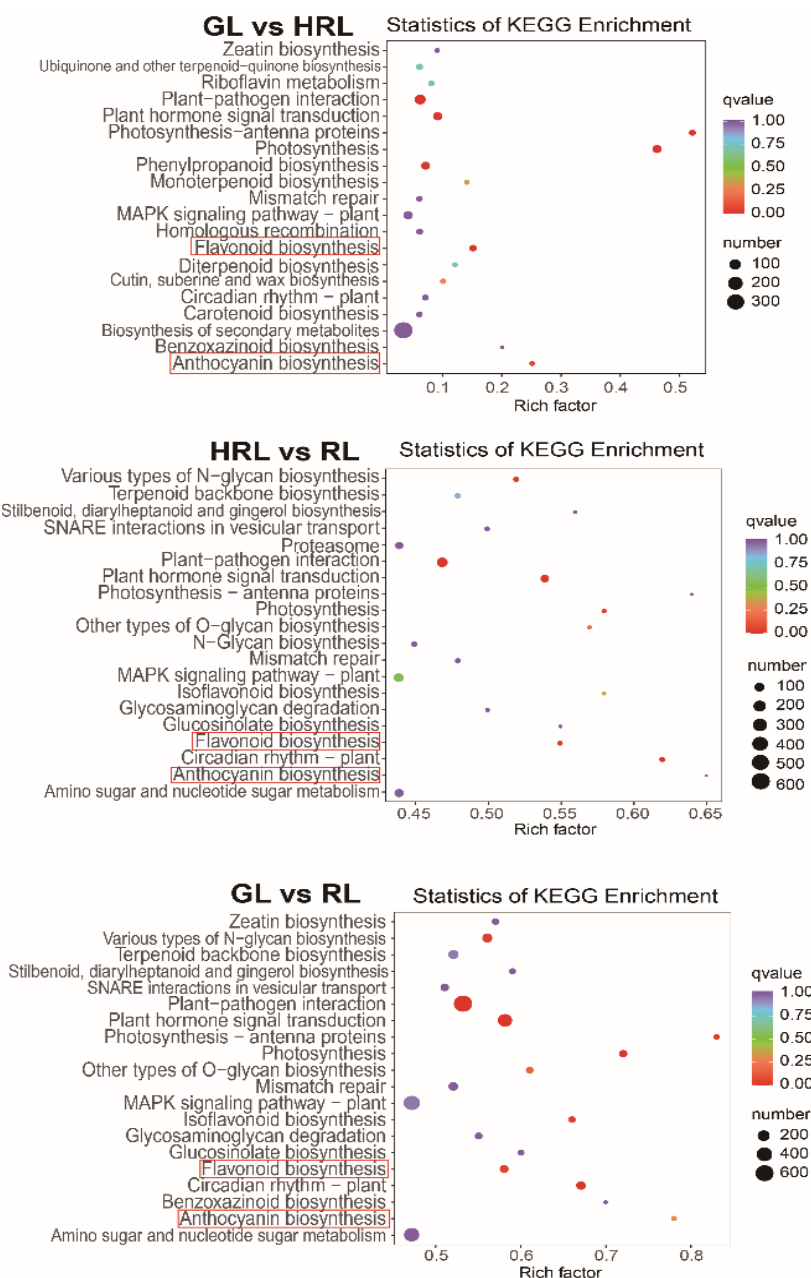
Figure 6. KEGG enrichment analysis of the DEGs in each comparison. The red dots highlight the flavonoid biosynthetic process and flavonoid metabolic process. flavonoid biosynthetic process and flavonoid metabolic